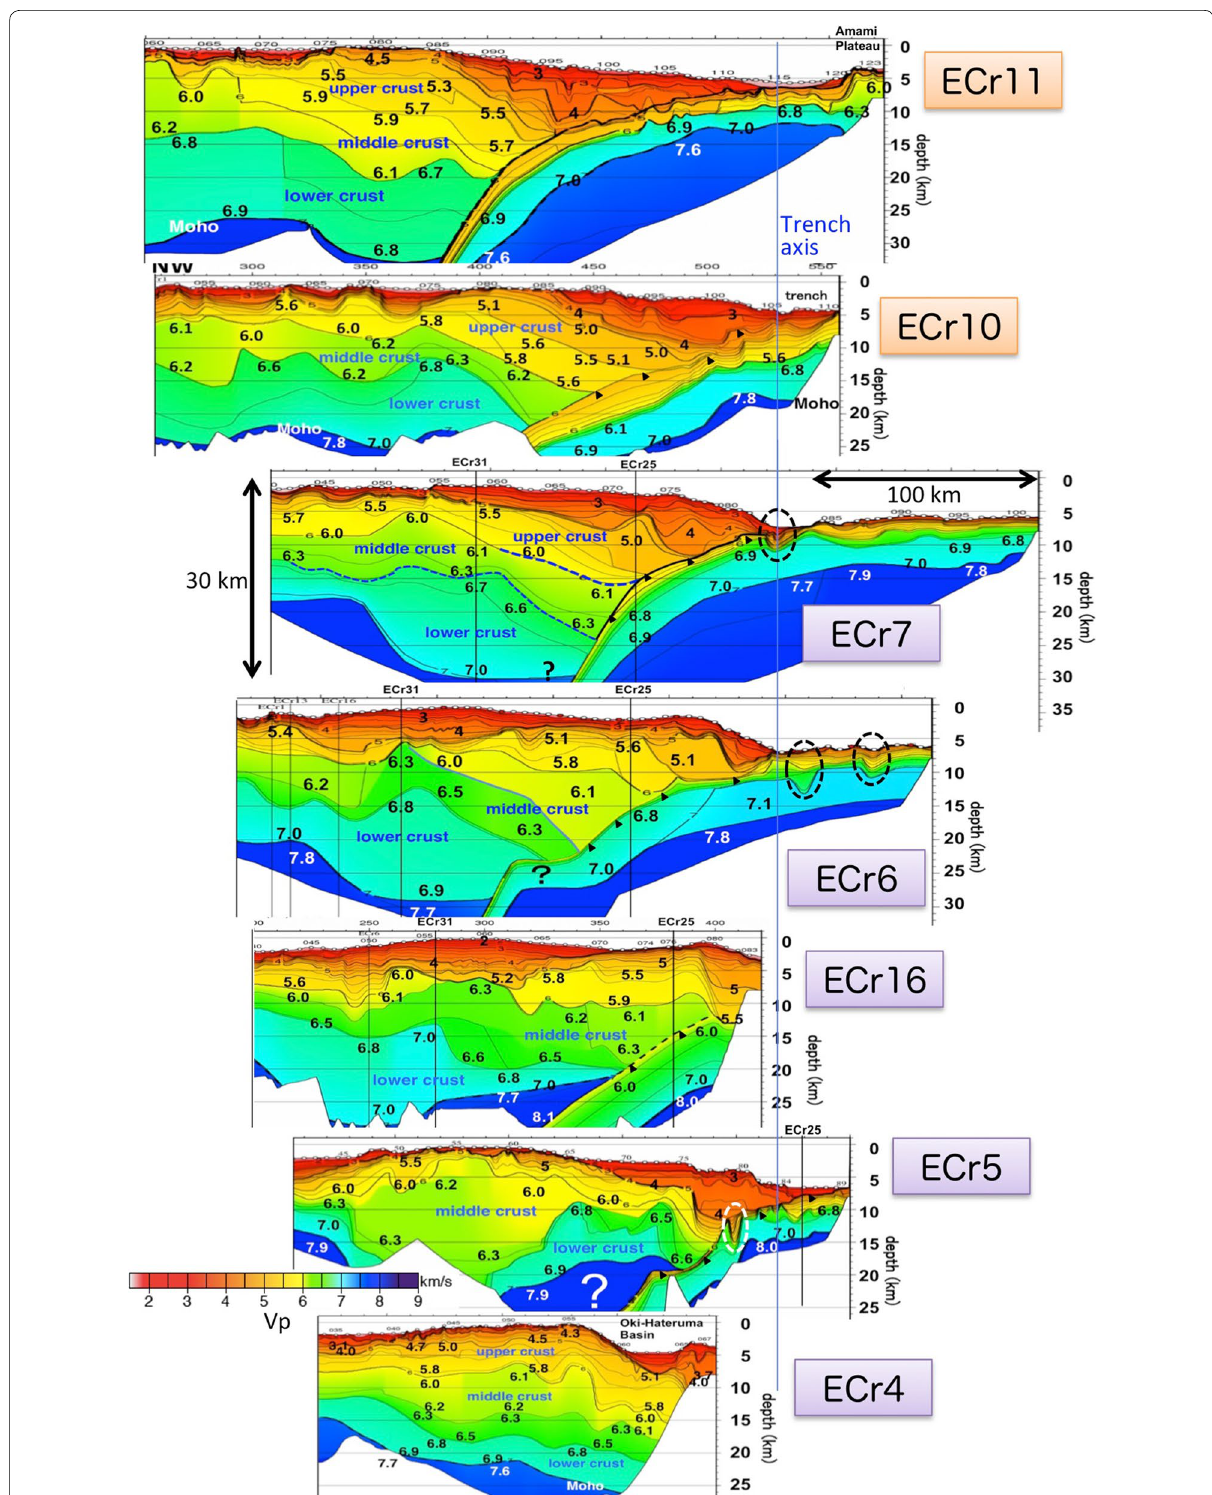
Fig. 4 P -wave velocity models for the survey lines perpendicular to the trench axis. The contour interval is 2.5 km/s. The vertical blue line shows the position of the trench axis. The triangles and dashed ellipses indicate the estimated positions of the subducting PHS plate interface and the fracture zone,